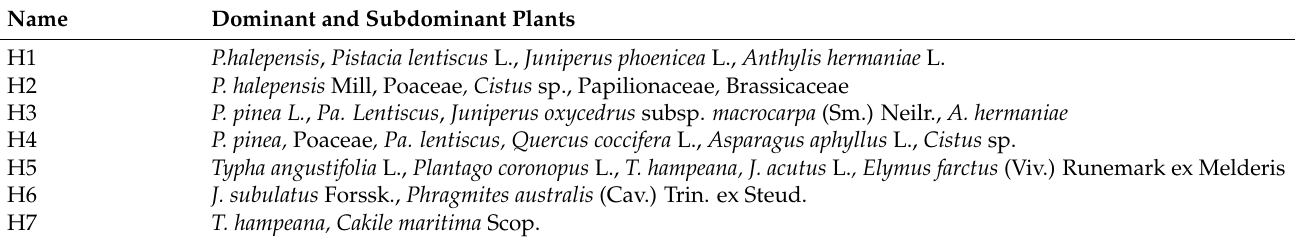
Table 1. Habitats and the major plant species grown in the Schinias coastal pinewood area. Photos of these plants are in Figure